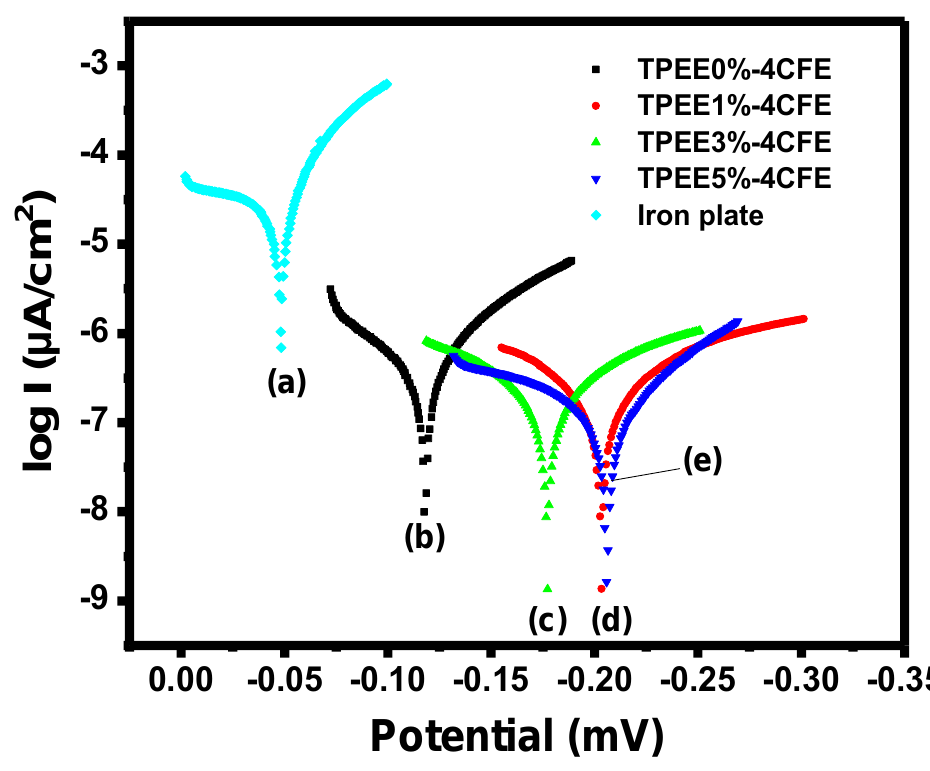
Figure 6. Tafel plot of the corrosion protection of ( a ) iron plate, ( b ) TPEE0%-4CFE, ( c ) TPEE3%-4CFE, ( d ) TPEE1%-4CFE, and ( e ) TPEE5%-4CFE. Table 2. Electrochemical corrosion measurements of a bare iron plate and TPEEn%-4CFE.